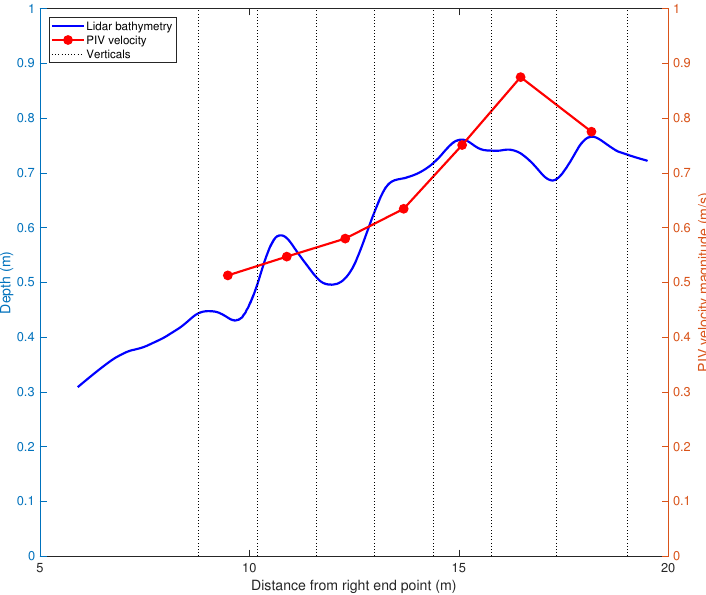
Figure 7. PIV-derived velocities, lidar depths, and left and right edges for each vertical used in the incremental discharge calculation for cross section 1 based entirely on remotely sensed data.